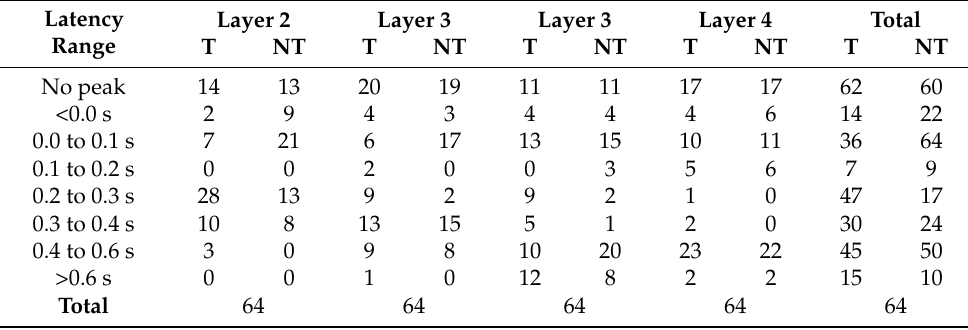
Table 1. Model hidden unit classifications by peak latency.